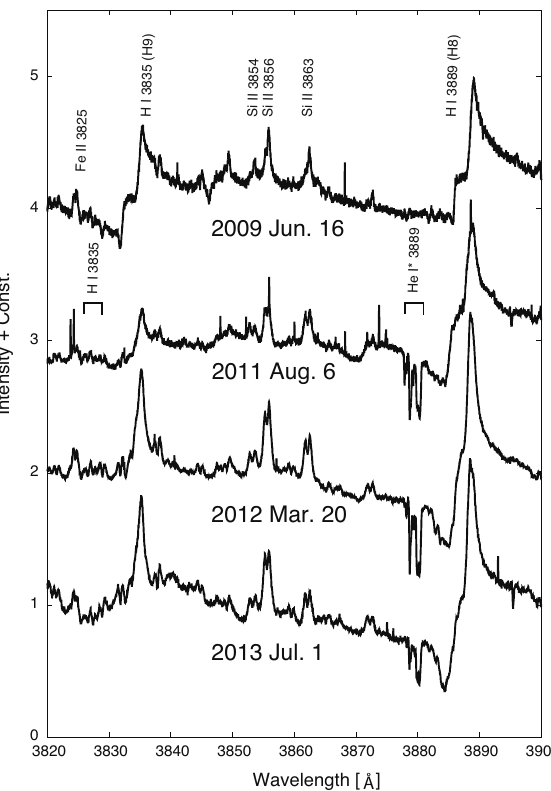
Figure 3: Multiple high velocity absorption lines as- sociated with He i*